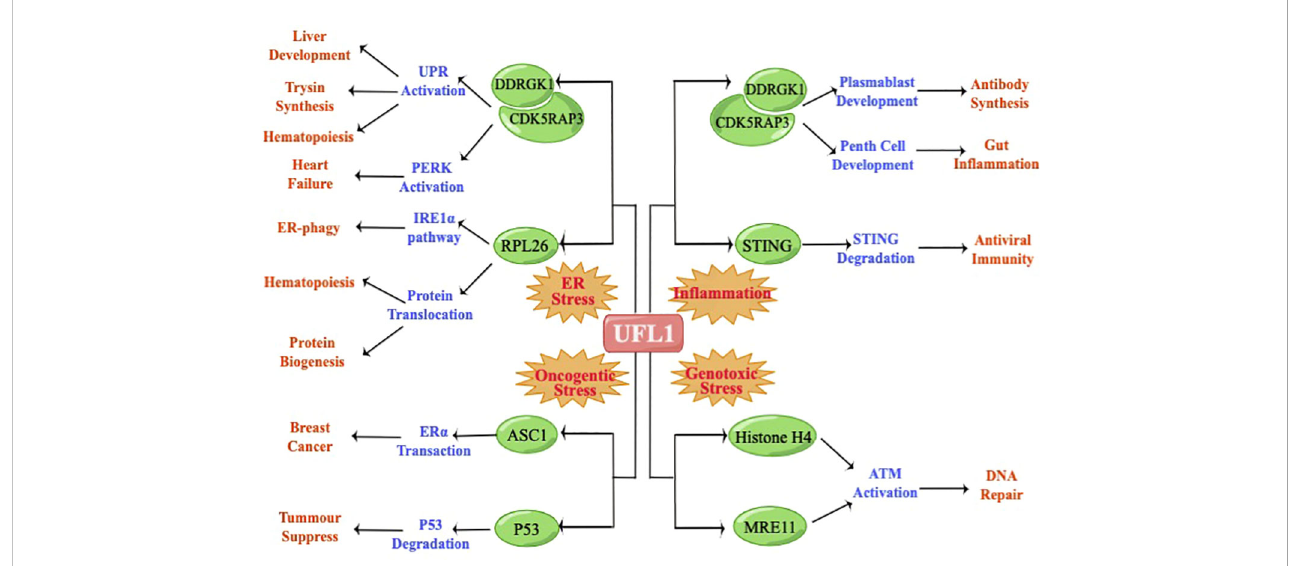
FIGURE 2 UFL1 regulate different physiological processes depending on the stimulus and the cellular